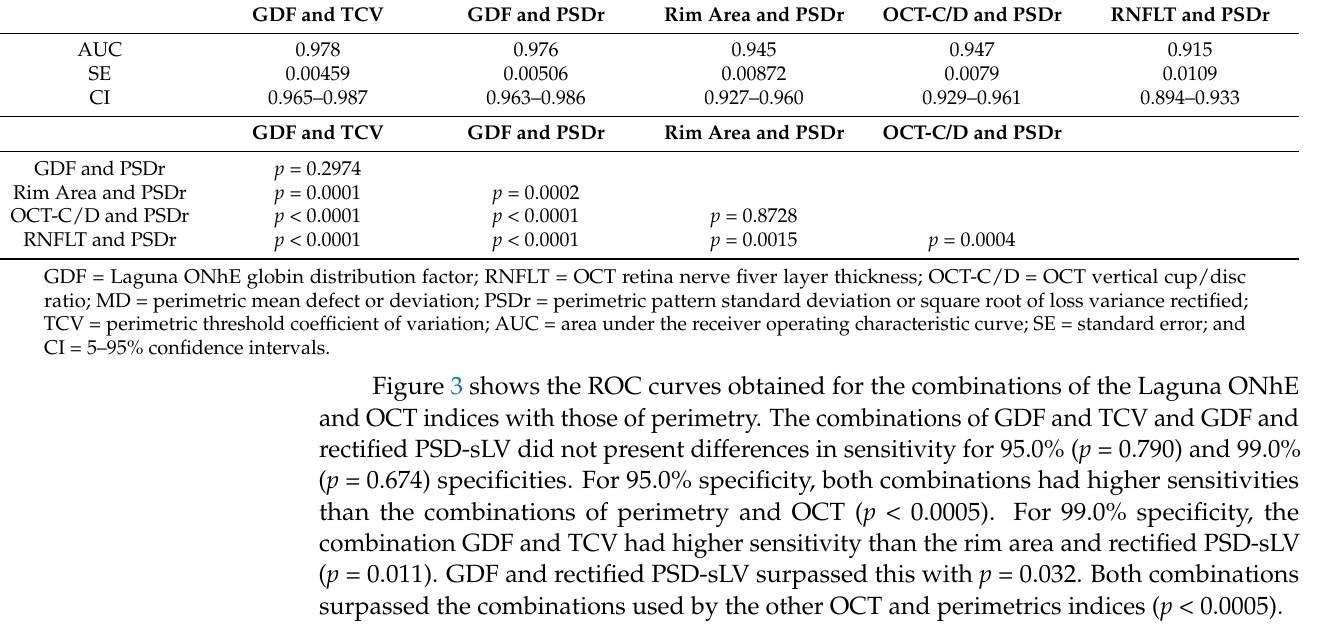
Table 2. Performance of the combination of Laguna ONhE and Cirrus-OCT variables and perimetric variables.